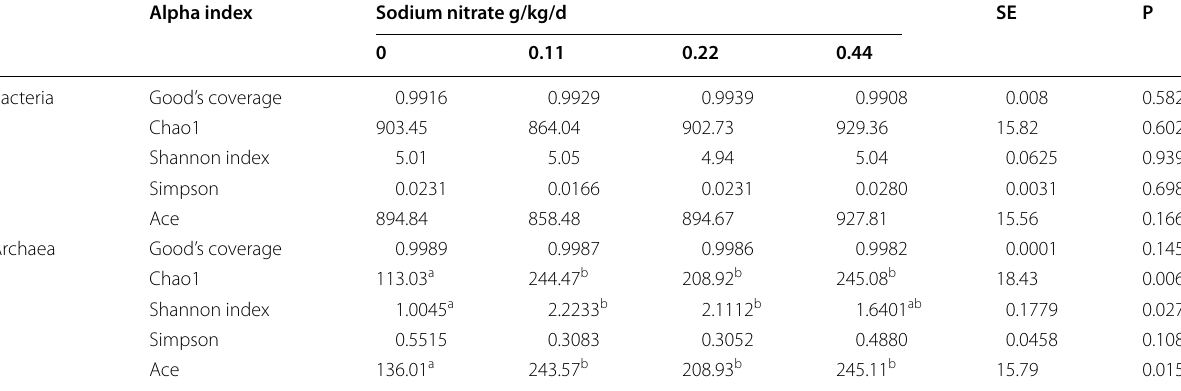
Different letters in the same row means significant differences ( P < 0.05)